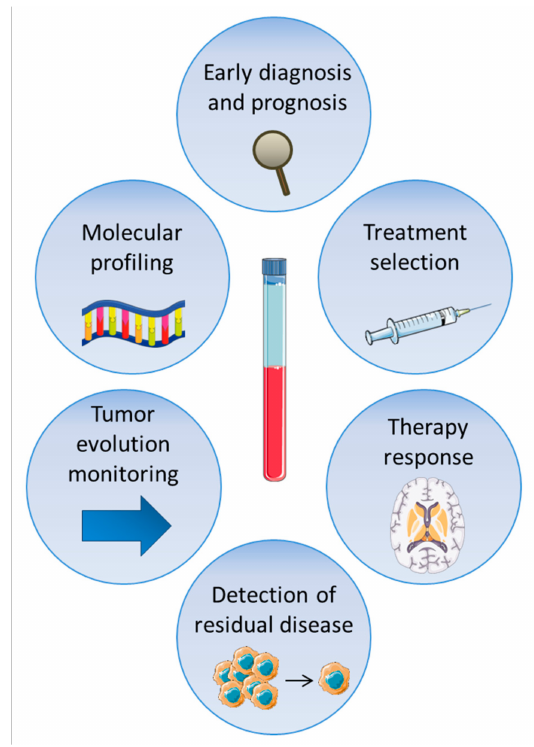
Figure 2. Potential applications of liquid biopsy in glioblastoma. The di ff erent circulating molecules may beappliedtoguideinitialdiagnosis, prognosisprediction, themolecularprofilingofthetumor, treatment planning, patient follow-up, tumor evolution monitoring and the detection of glioblastoma